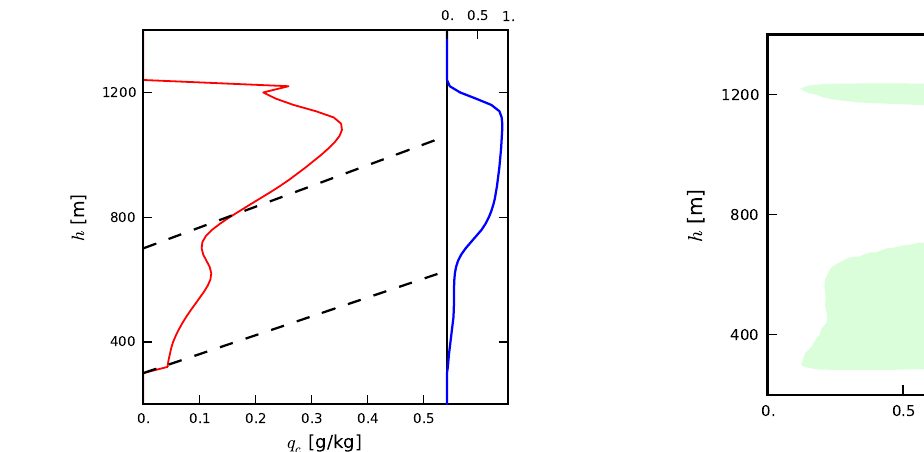
Fig. 8. Average profiles of the conditionally sampled in-cloud cloud water mixing ratio. The black dashed lines show the adiabatic liq- uid water content for cumulus and stratocumulus layers assuming cloud base at height 300 and 700m, respectively. The cloud frac- tion profile is shown on the right-hand side of the panel with the blue line.